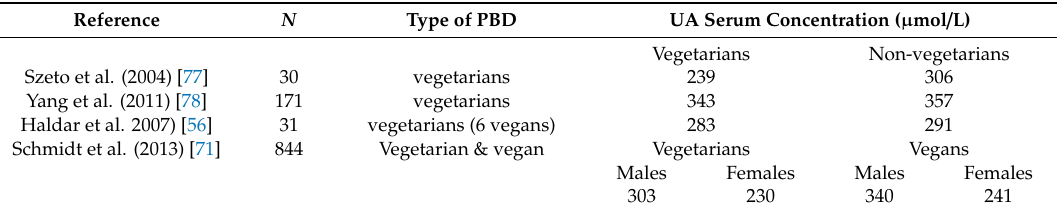
Table 1. Comparison of serum UA concentrations in vegetarians and nonvegetarians in cross-sectional